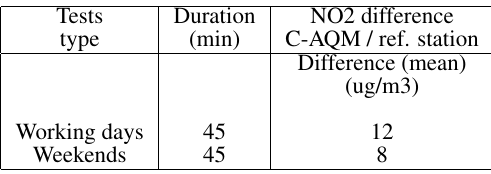
Table 4. NO2 estimated error at checkpoints.